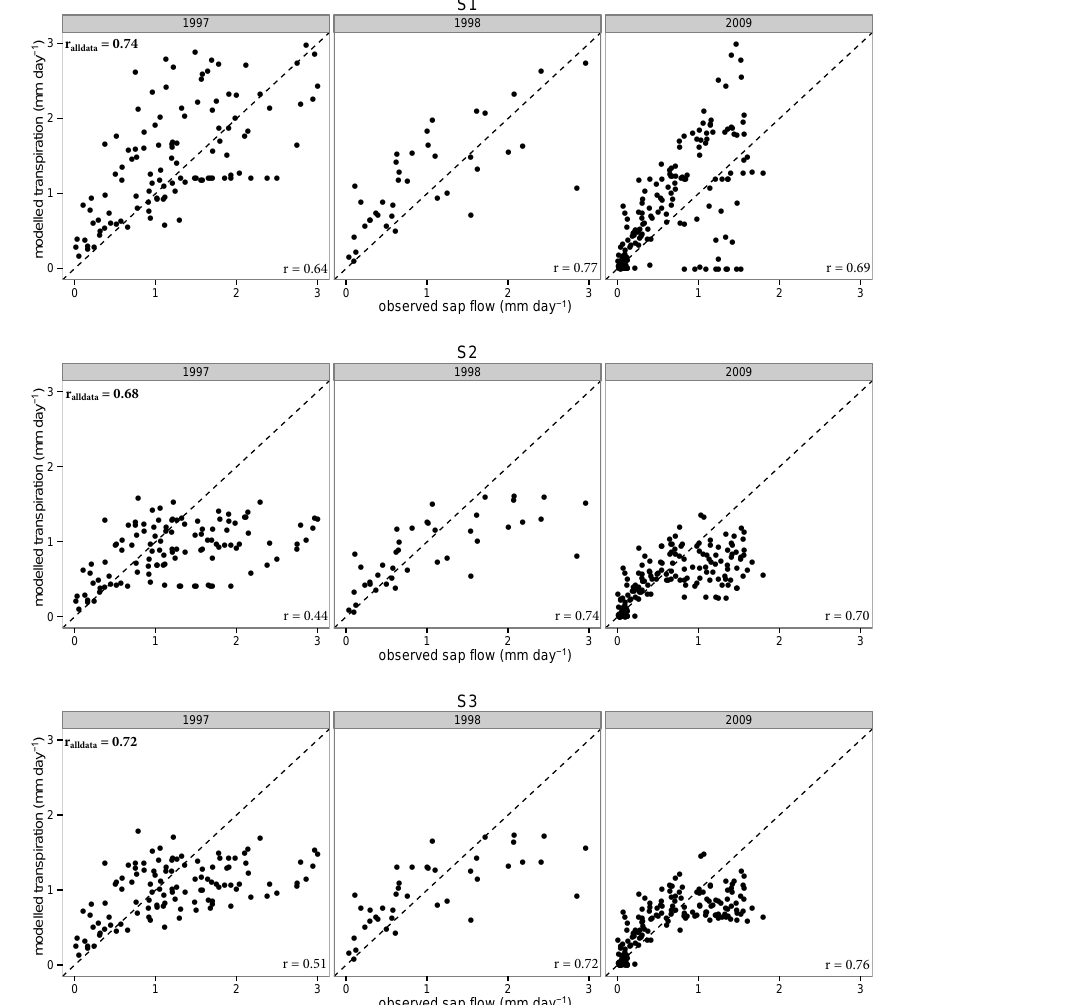
Figure 8. Modelled transpiration (mmday − 1 ) for Pinus sylvestris , compared to observed sap flow (mmday − 1 ). Pearson correlation coeffi- cients significantly different from 0 ( P< 0 . 01) for all separate years as well as all data points together ( r alldata ). Sap flow measurements for 1997 and 1998 acquired using tissue heat balance systems, and for 2009 using Granier thermal dissipation probes. S1 is default uptake, S2 is species-specific uptake, S3 is linear